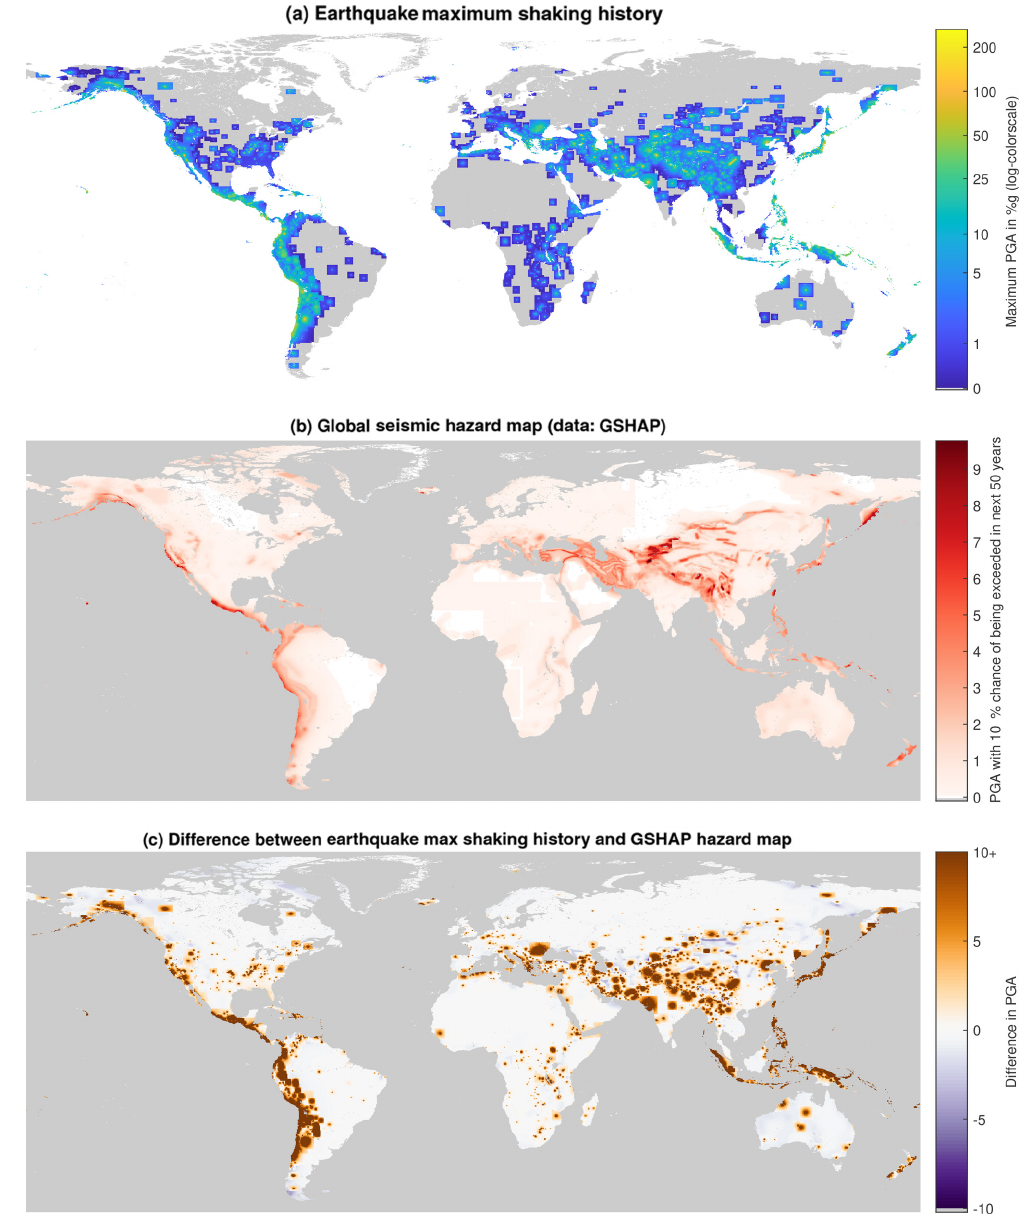
Figure E1. Comparing the earthquake maximum shaking history with the GSHAP hazard map. Panel (a) shows the maximum shaking experienced between 1973 and 2015, and panel (b) plots the GSHAP data of probabilistic PGA estimates that will not be exceeded with a 90% chance within 50 years. Subtracting (b) from (a) results in the difference between actual exposure and the probabilistic estimates, which is displayed in panel (c) . The scale is cut off at a difference of 10%g. This comparison reveals that the maximum shaking history for the given time range tends to exceed the GSHAP estimates in most seismically active regions of the world. It is important to keep in mind that the shaking history is a combination of observed and estimated data for actual shaking exposure in the given time